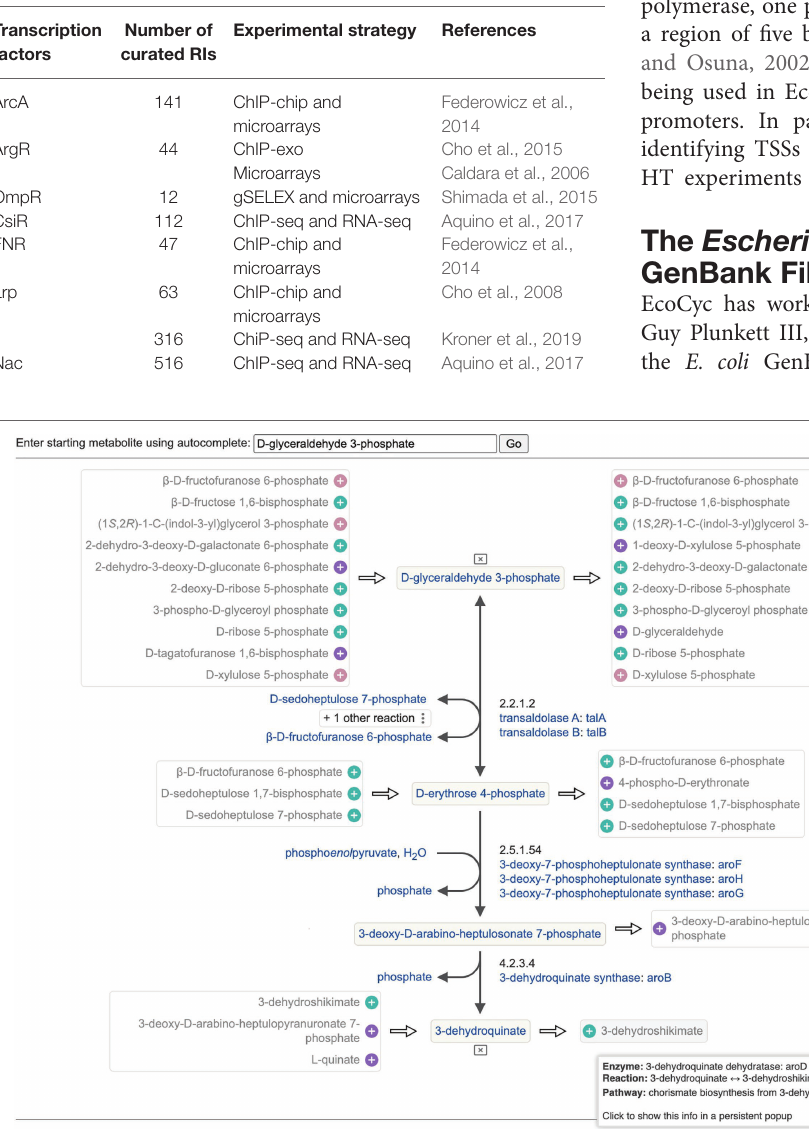
TABLE 3 | Transcription factors and their regulatory interactions (RIs) extracted from high-throughput experiments.